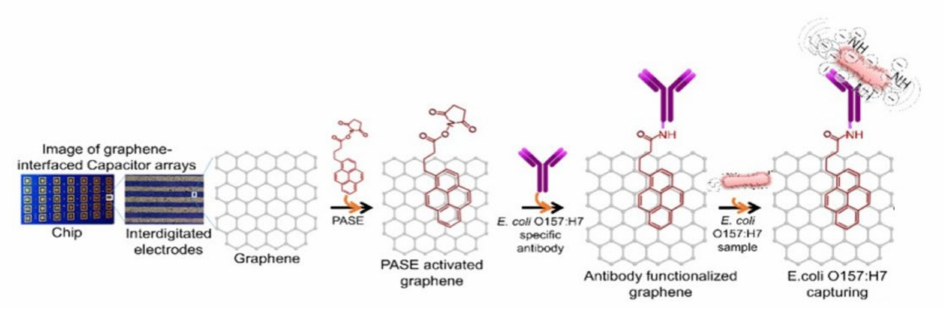
Figure 6. Scheme of a graphene chip and the process of PASE activation and antibody immobilization. Adapted with permission from [87] Copyright 2017,